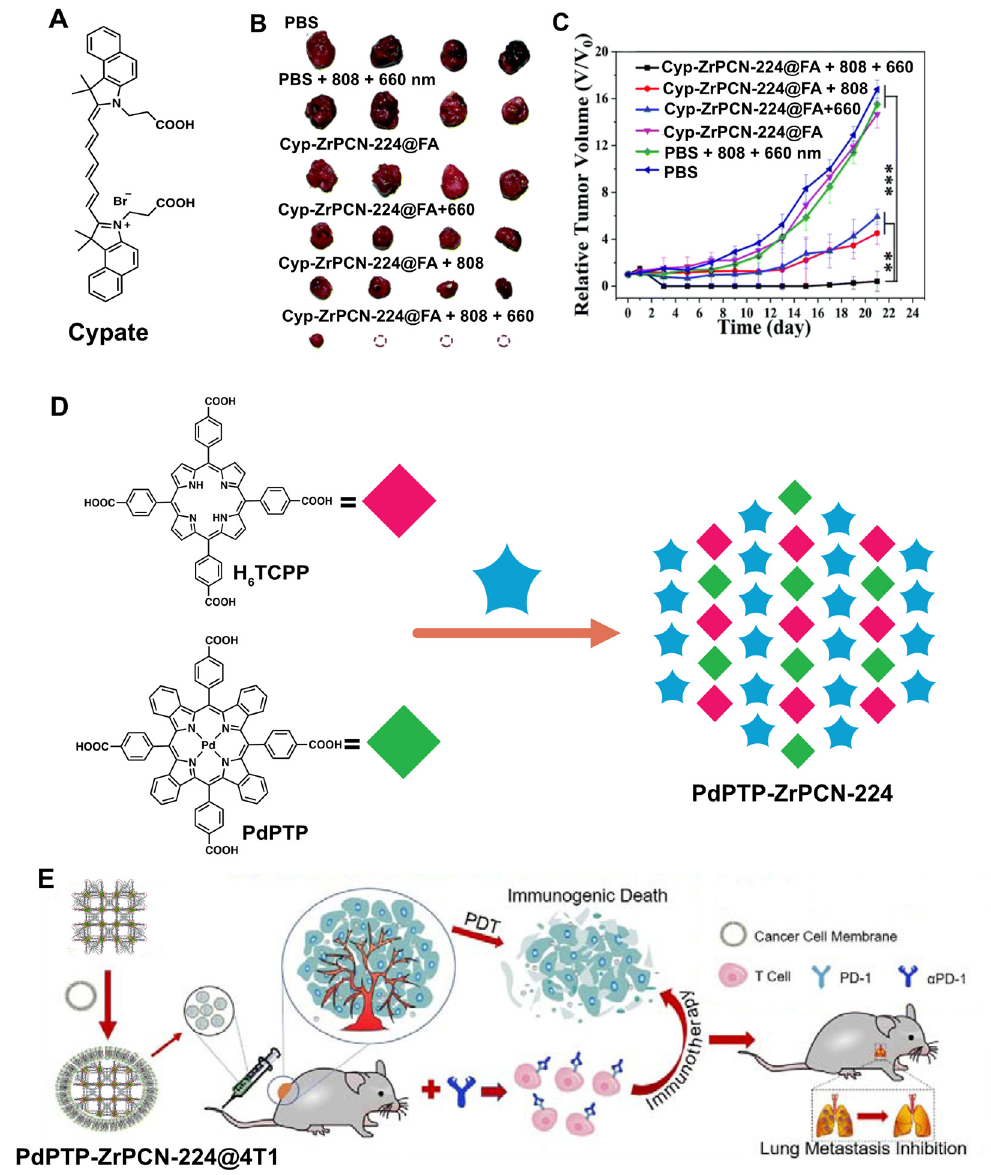
Figure 8. ( A ) Organic compound used to prepare Cyp-ZrPCN-224. ( B ) photos of ex vivo tumours with different treatments with Cyp-ZrPCN-224 after 21 days. ( C ) Relative tumour volumes of six groups of mice that received different Cyp-ZrPCN-224 (15 mg kg − 1 ) treatments. ( D ) Schematic illustration of the synthesis and application of PdPTP-ZrPCN-224. ( E ) The PDT and α PD-1 checkpoint blockade combined therapeutic effects of PdPTP-ZrPCN-224@4T1. Reprinted/adapted with permission from Refs. [96,97]. (Data are presented as the mean ± SD ( n = 4). **, p < 0.01; ***, p < 0.001). Xie and co-workers used a similar approach to include a co-ligand into the ZrPCN- 224 network to boost both the PDT effect and the near-infrared (NIR) O 2 concentration ratiometric imaging. This approach addressed a number of limitations associated with short detection wavelengths and the influence of self-concentrations. This was possible by doping ZrPCN-224 with an extended π -conjugated palladium porphyrin (Pd-tetrakis(4- methoxycarbonylphenyl)-tetrabenzoporphyrin) (PdPTP, Figure 8D) [97]. 4T1 cell mem- brane extraction and PdPTP-ZrPCN-224 coating yielded a cloaked nanomaterial (PdPTP- ZrPCN-224@4T1) capable of targeting in vivo solid tumours with high efficiency, and effectively suppressing tumour growth via PDT. The increased PDT effect of PdPTP medi- ated a strong immune activation by inducing cancer immunogenic cell death (Figure 8E).